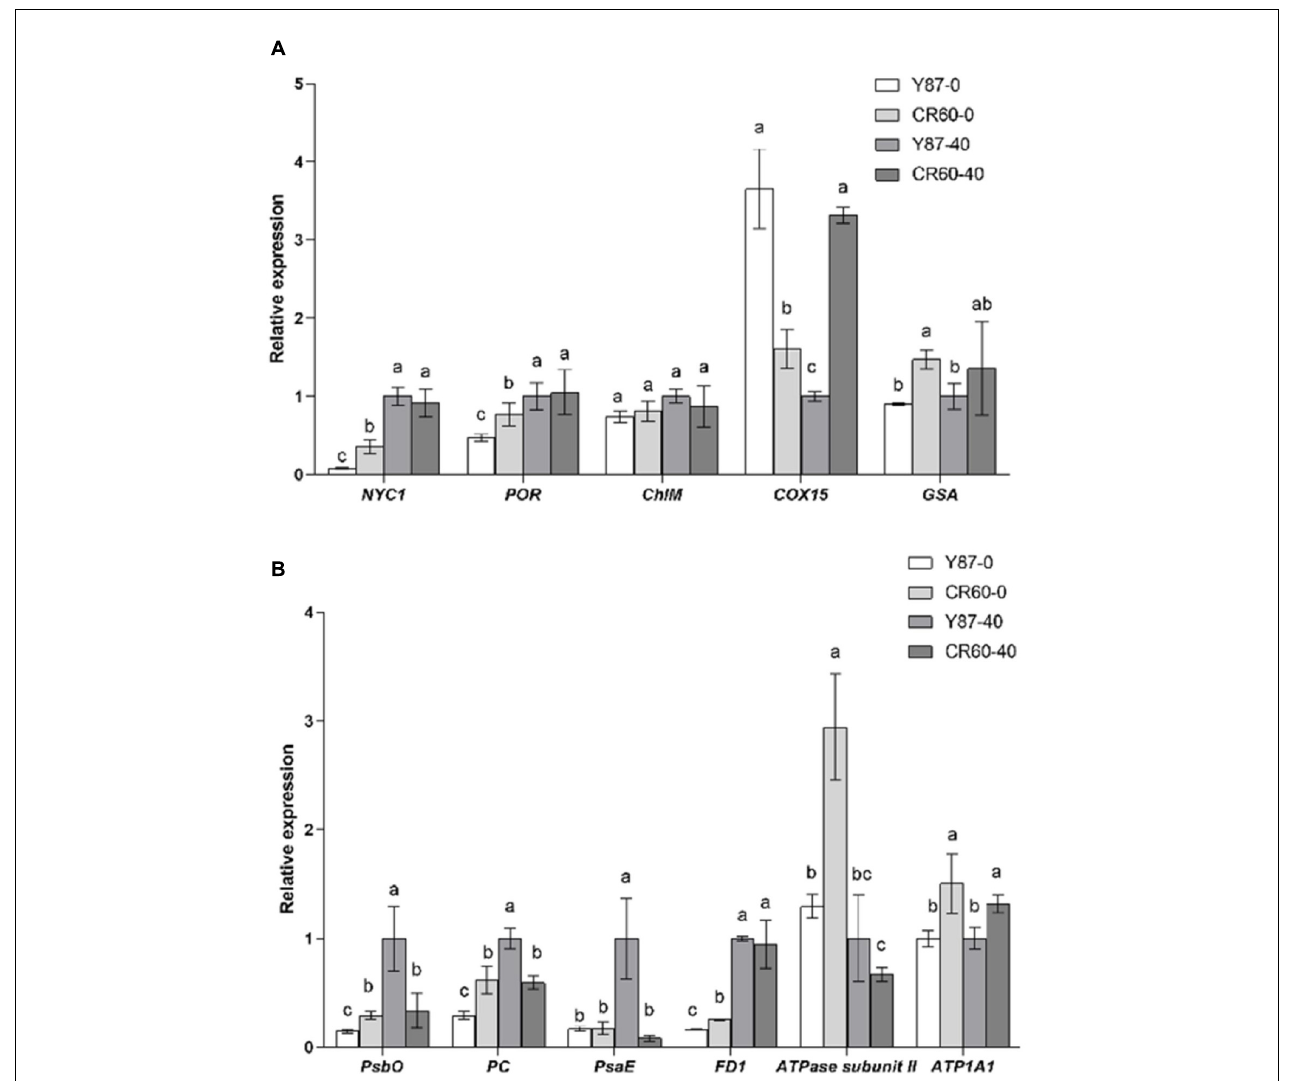
FIGURE 6 | Expression of genes associated with chlorophyll synthesis (A) and photosynthesis (B) in the first fully expanded apical leaves of Y87 and CR60. The plants were grown in 1/2 Hoagland nutrient solutions containing 0 or 40 µ M Fe (III)-EDTA for 21 days. The data are expressed as means ± SD ( n = 3). Different letters indicate significant differences at P < 0.05 (Student’s t